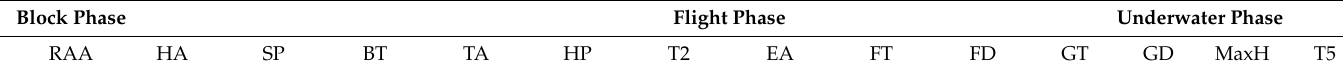
Table 3. Correlations between swim start